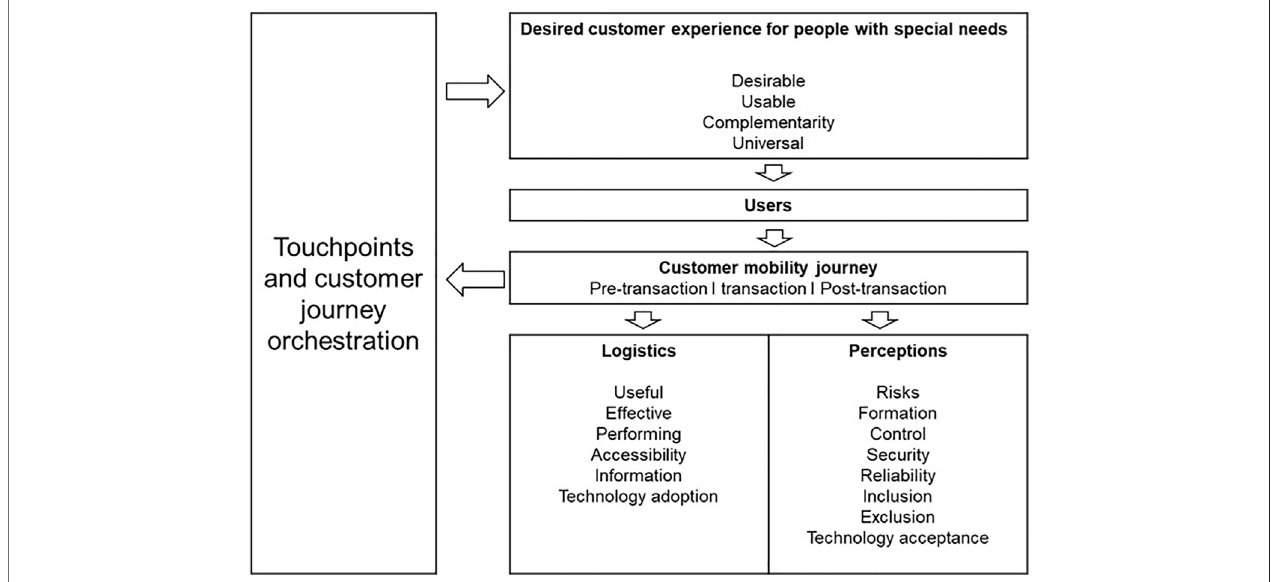
FIGURE 5 | Touchpoints and customer journey orchestration into customer experience.